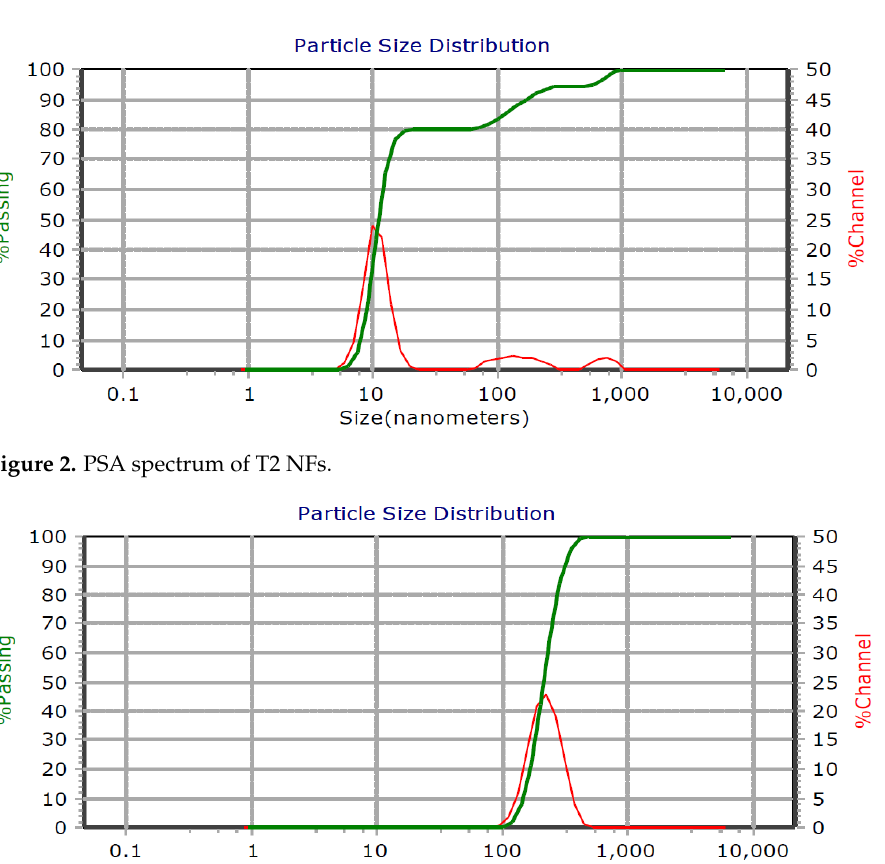
Figure 3. PSA spectrum of T3 NFs. The efficacy of synthesized and characterized NFs (T1, T2 and T3) was checked by examining their antimicrobial activity and DPPH radical scavenging activity. Antimicro-